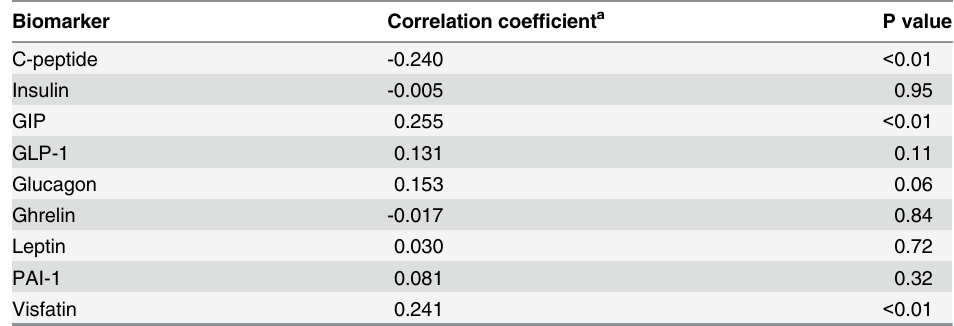
Table 4. Correlations between number of sites with PD (cid:1) 4mm and the amounts of the detected biomarkers.